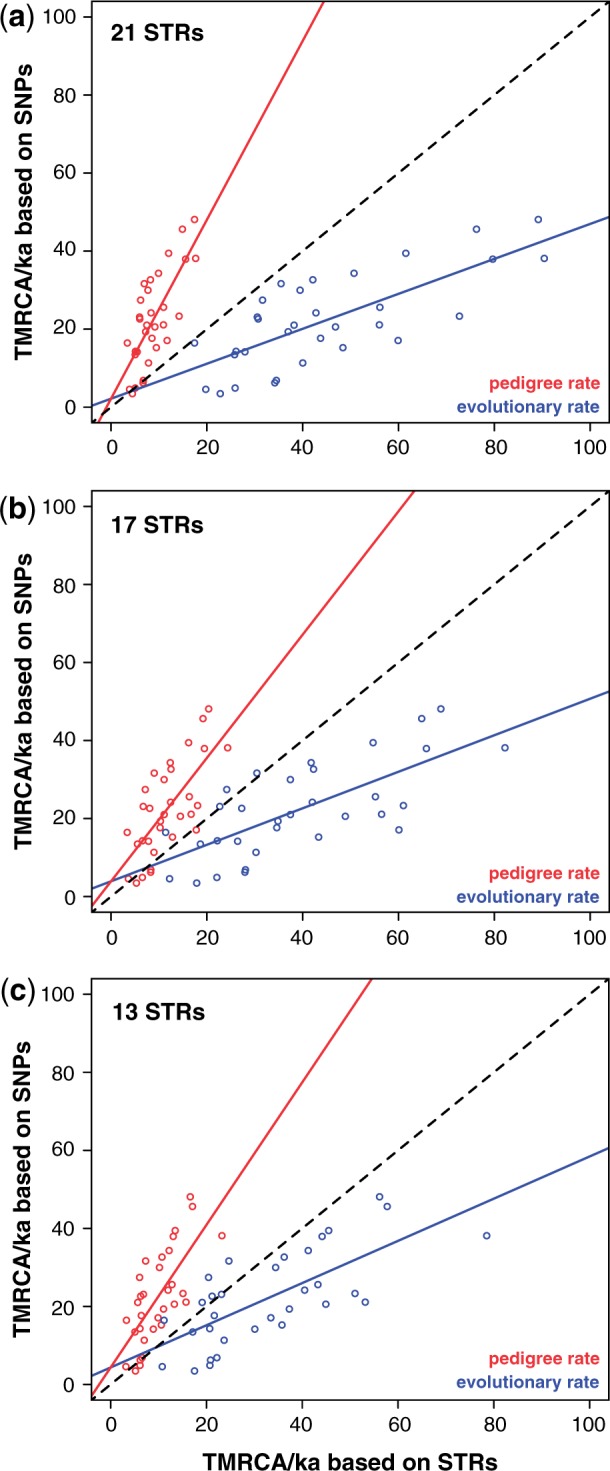
Relationship between SNP- and STR-based TMRCA estimates. SNP-based node estimates are plotted against STR-based estimates for (a) 21 STRs, (b) 17 STRs, and (c) 13 STRs, here using ASD with the “ancestral haplotype” root specification. The black dashed line in each case indicates x = y. Underlying data and correlation coefficients are given in supplementary tables S6 and S7, Supplementary Material online.